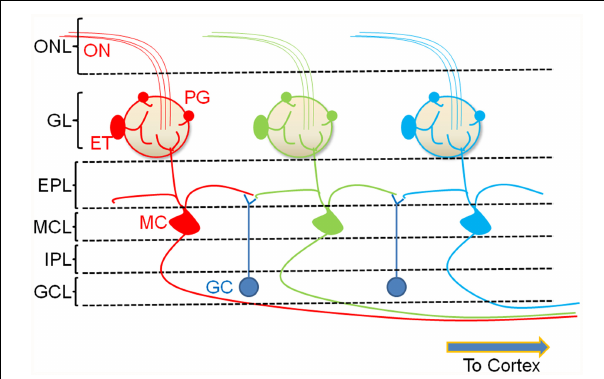
FIGURE 1 |A simplified cartoon of the bulbar circuit. ORNs in the nasal epithelium send their axons ON to the glomerular layer of the OB. Each glomerulus receives convergent ON input from ORNs that recognize the same odor epitope (color coded). Resident interneurons in the juxtaglomerular region receive ON input and modulate glomerular signaling. The two major glomerular interneuron classes are the glutamatergic external tufted (ET) cells and the GABAergic PG cells.Together, these cells regulate the glomerular output resulting in the excitation of MCs, the principal neurons of the OB. A second interneuron type, the granule cell (GC), forms dendrodendritic synapses with the lateral dendrites of the MCs.These neurons exert GABAergic control over multiple MCs resulting in lateral inhibition.The modulated output of the MC is then transmitted to the pyriform cortex. ONL, olfactory nerve layer; GL, glomerular layer; EPL, external plexiform layer; MCL, mitral cell layer; IPL, internal plexiform layer; GCL, granule cell